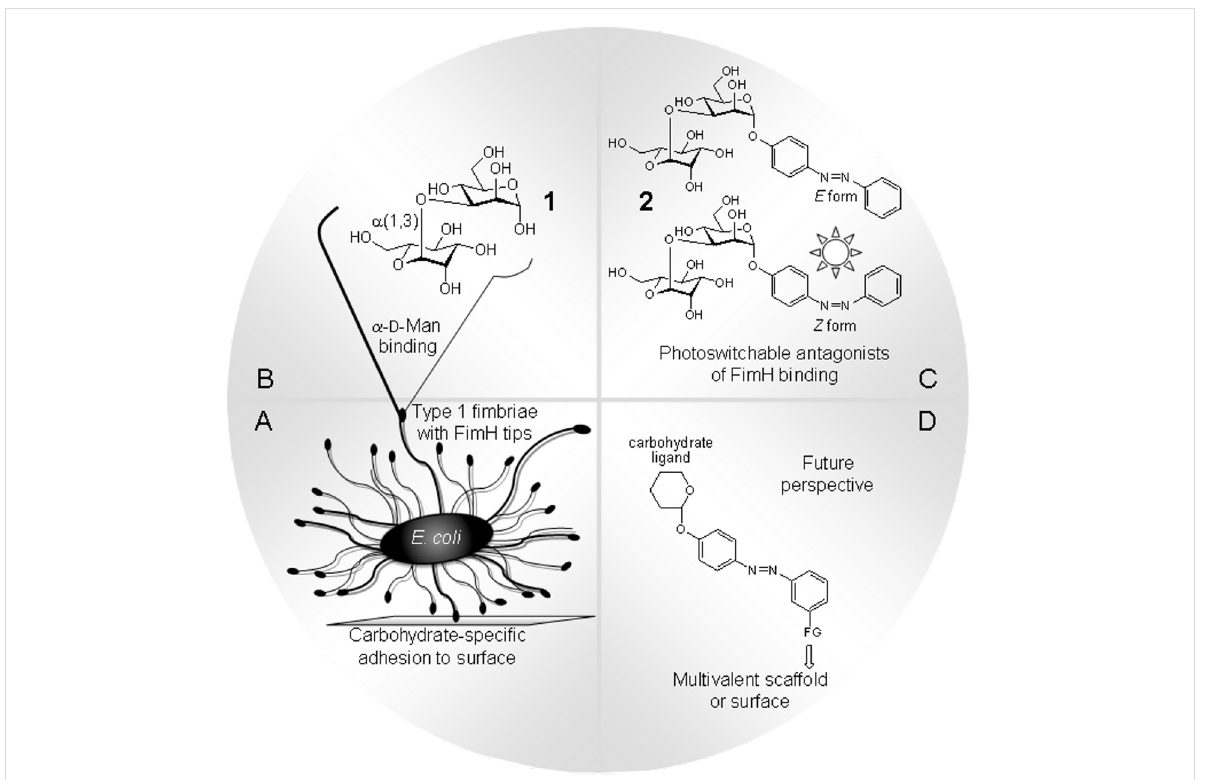
Figure 1: The α -(1 → 3)-linked mannobioside α -D-Man-(1 → 3)-D-Man 1 (B) is a potent disaccharide ligand for the bacterial lectin FimH and can thus inhibit type 1 fimbriae-mediated bacterial adhesion to glycosylated surfaces (A). Introduction of an azobenzene aglycone moiety turns glycoside 1 into a putative photoswitchable antagonist 2 of mannose-specific bacterial adhesion, displaying an ( E )-, as well as a ( Z )-form (C). In a future perspective azobenzene glycosides such as 2 can be further functionalised to be attached to oligofunctional core molecules or immobilised on surfaces (D).